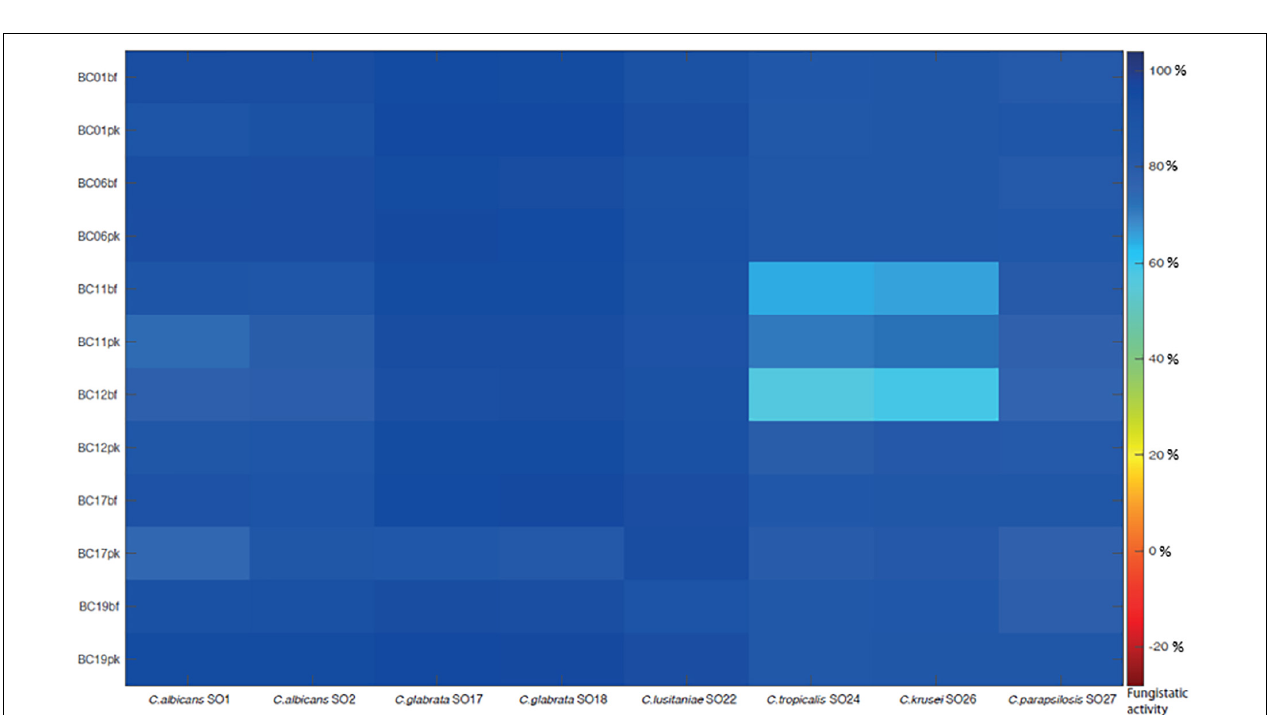
FIGURE 2 | Fungistatic activity of Lactobacillus bf-CFS and pk-CFS toward clinical Candida isolates, tested following EUCAST guidelines (pH 7). OD 530 nm values were normalized for positive controls and data were expressed as inhibition (%) of Candida growth. Fungistatic activity color scale was reported (10% activity variation).